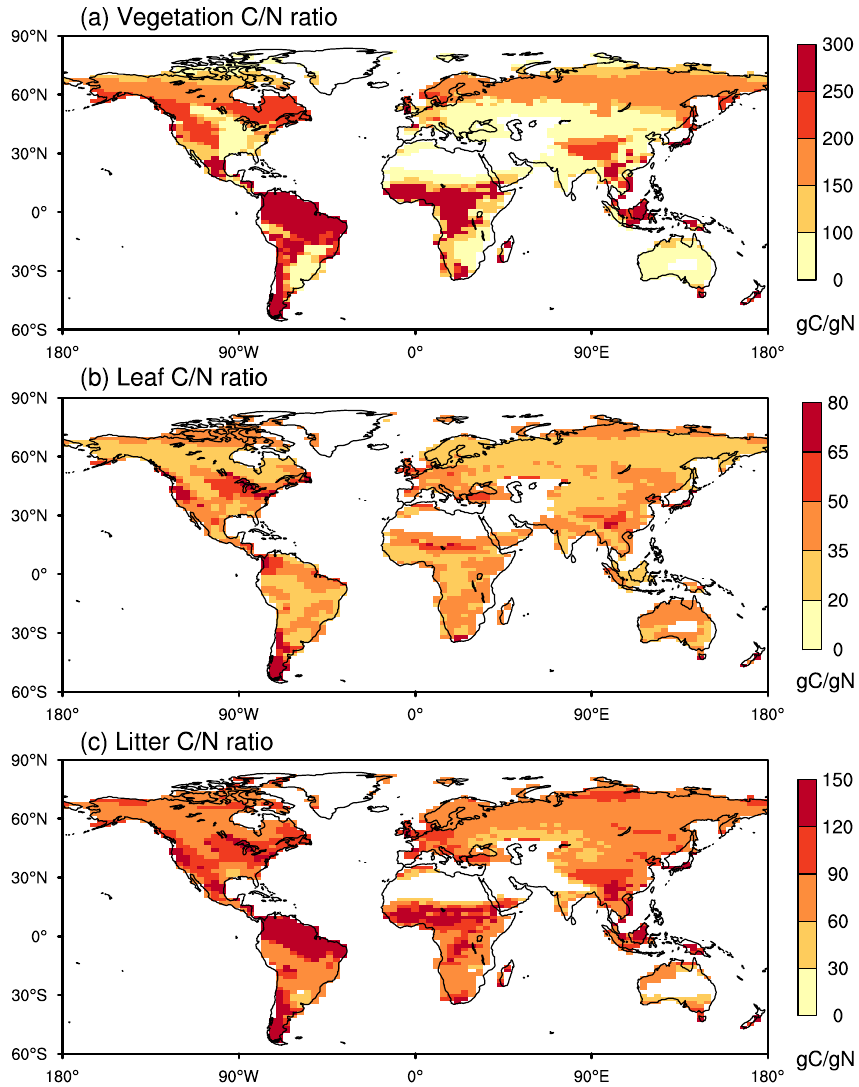
Fig. 3. Mean 1980–1999 C/N ratios of vegetation (a) , leaves (b) and litter (c) simulated by UVic-CN.